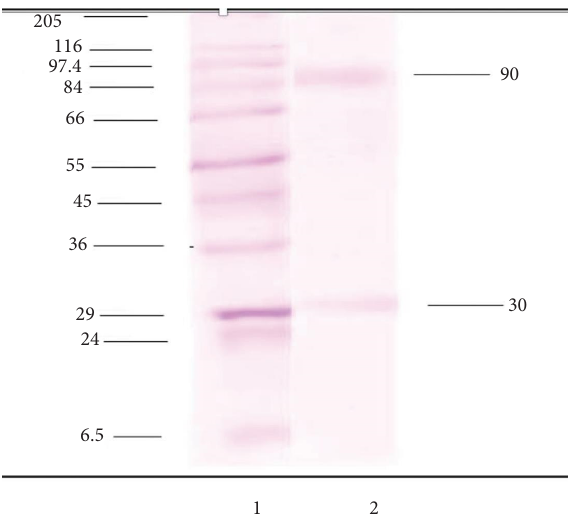
Figure 3: Western blot analysis. Lane 1: molecular marker. Lane 2: afnity purifed mrigal IgM.